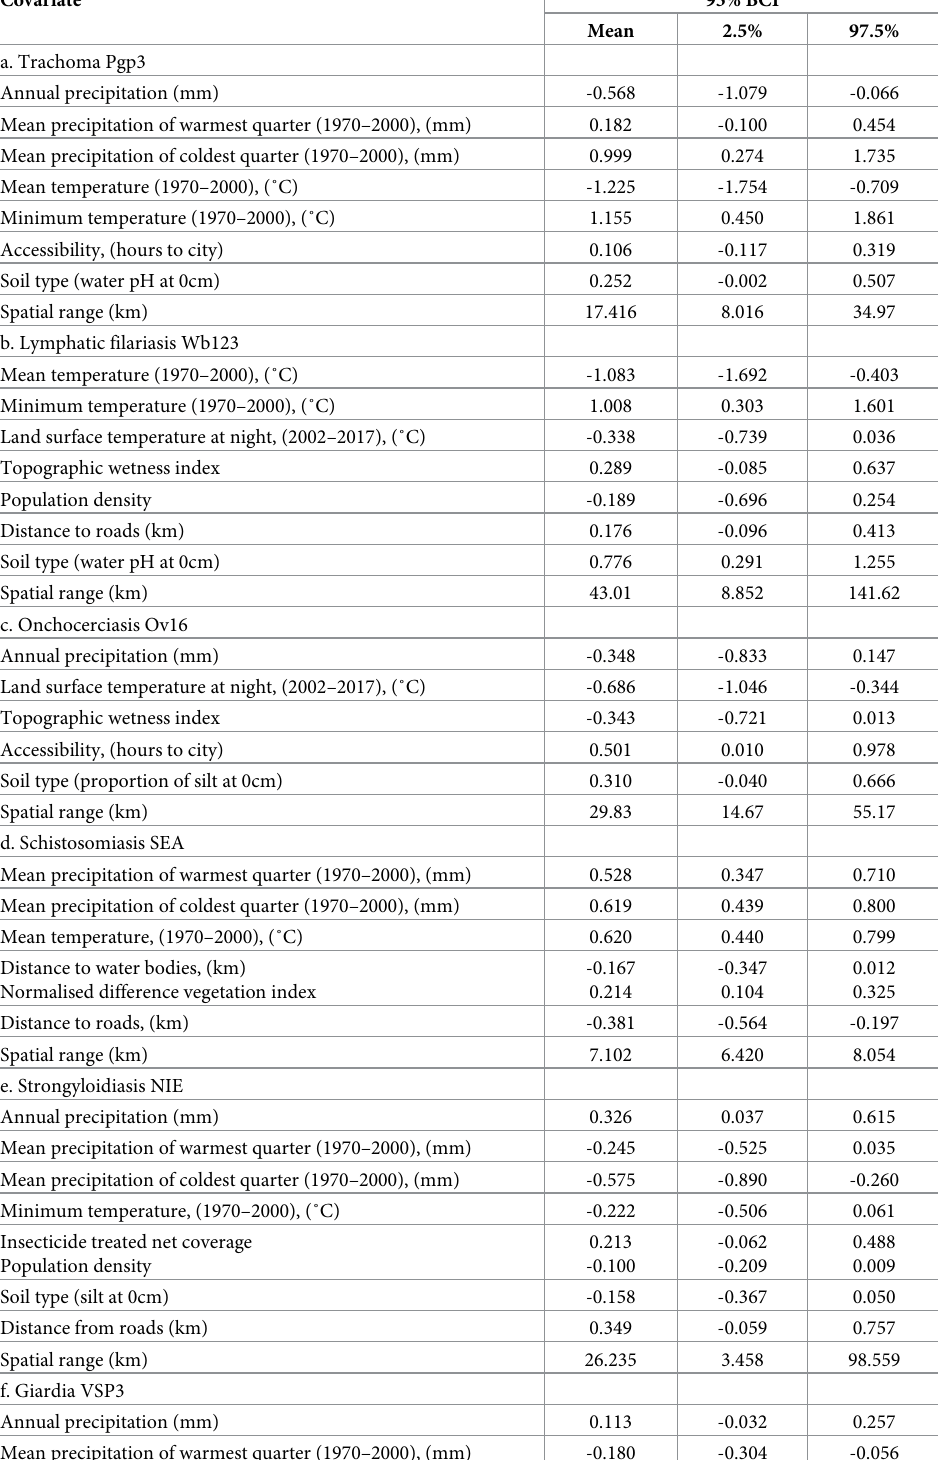
Table 2. Mean posterior estimates of coefficients of fixed effects and spatial range, including 95% Bayesian credi- ble intervals